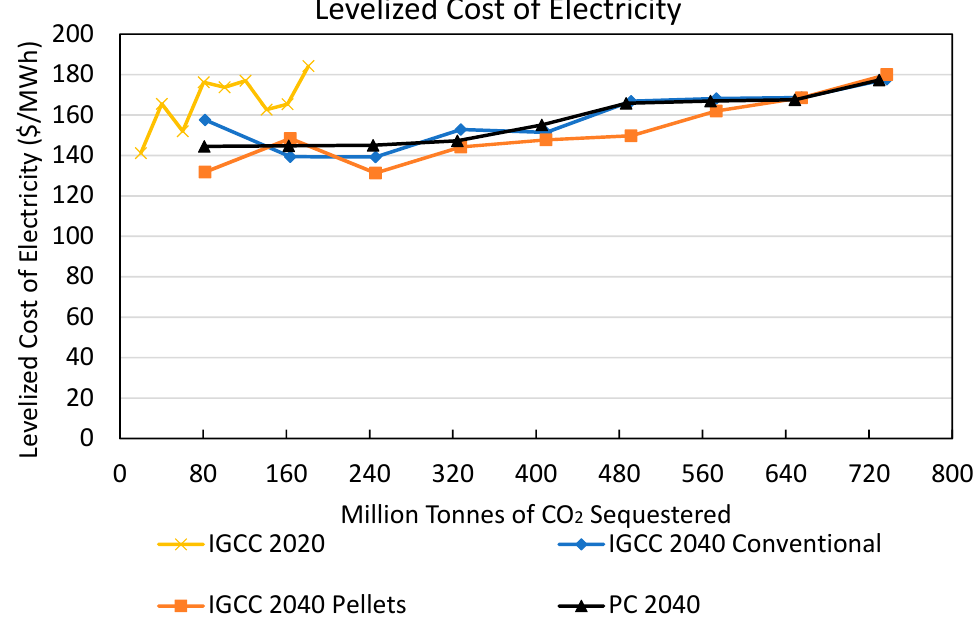
Figure 8. Levelized cost of electricity (LCOE) under the four BECCS scenarios: 2020 IGCC conventional, 2040 IGCC conventional, 2040 pulverized combustion pellets, and 2040 IGCC pellets.